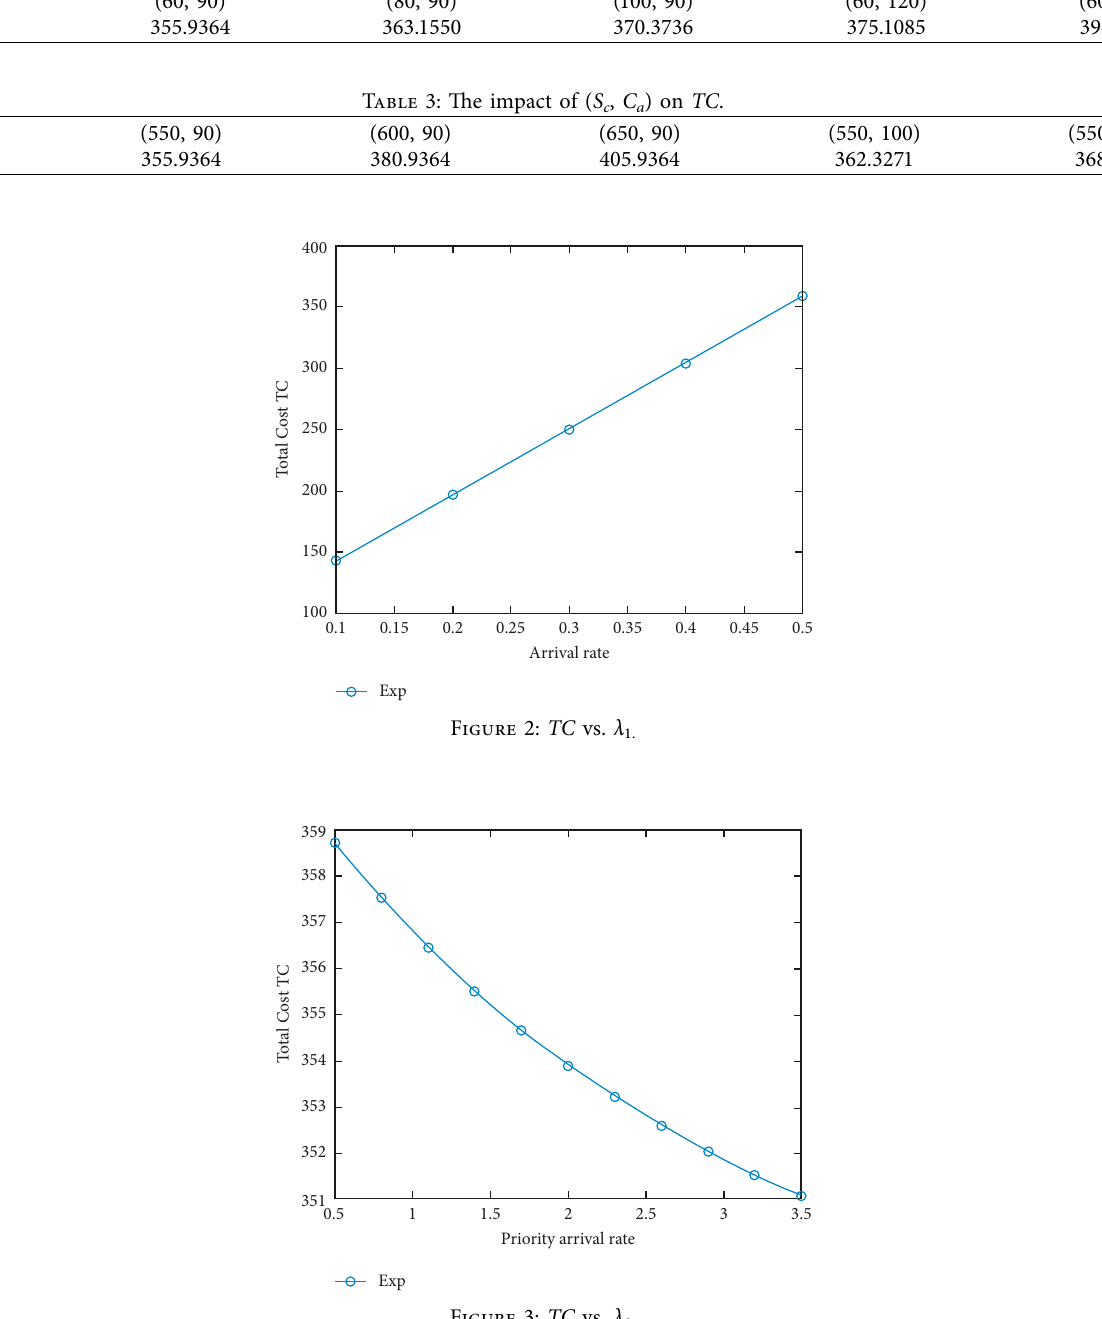
Figure 3: TC vs. λ